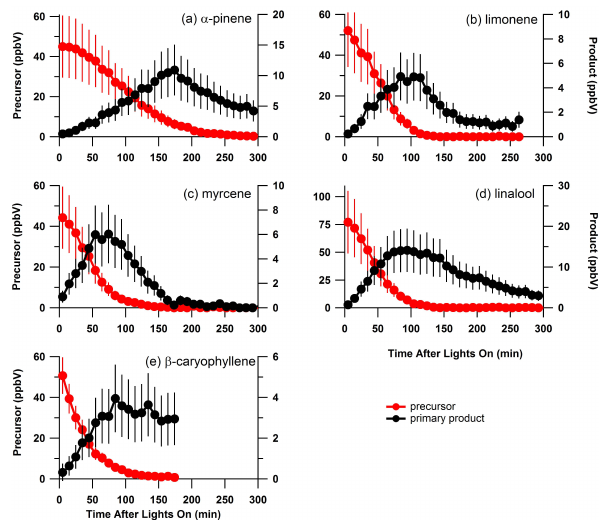
Fig. 1. Temporal profiles of each of the precursors investigated and their primary oxidation products: (a) α -pinene and pinonaldehyde (experiment 5, Table 1); (b) limonene and limononaldehyde (exper- iment 14, Table 1); (c) myrcene and 4-vinyl-4-pentenal (experiment 1, Table 1); (d) linalool and 4-hydroxy-4-methyl-5-hexen-1-al (ex- periment 3, Table 1); and (e) β -caryophyllene and β -caryophyllon aldehyde (experiment 10, Table